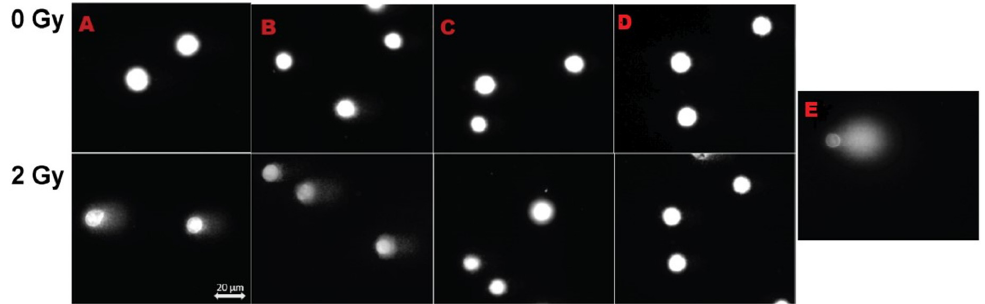
Figure 5. Representative images of the cells assayed by the comet assay. The nuclei was stained with diamond nuclei acid stain. Above, non-irradiated cells. Below, irradiated cells where A = negative control; B = cells treated with reversine, 5 μM; C = cells treated with CS-NP; D = cells treated with CS-NP + reversine, 5 μM; E = positive control, consisting of cells treated with 100 μM of H 2 O 2 . All the images were taken at 40× magnification.